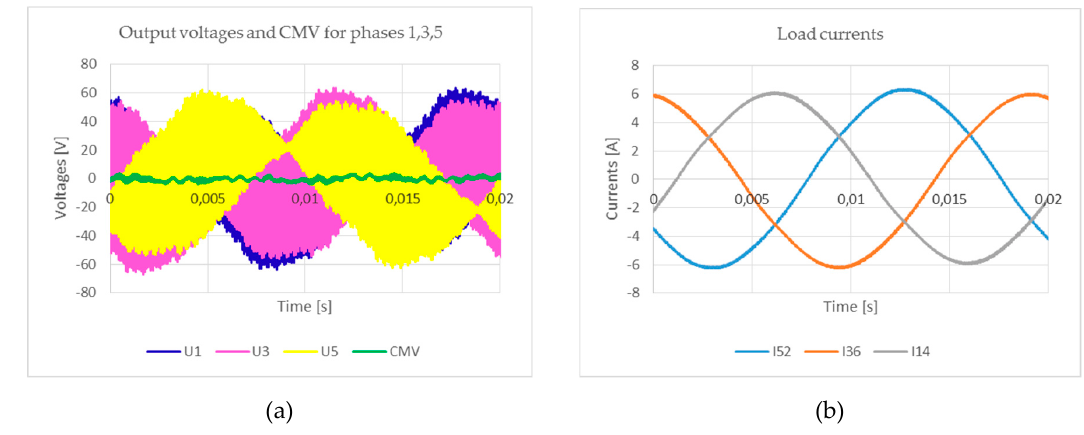
Figure 14. Waveform of the output phase voltages for phase 1,2 and 3 (dark blue, pink, yellow) and the CMV (green) (a), load currents (b), synthesized in the MC controlled by the use of the CCW rotating space vectors for three-phase open-end load and output frequency of 50 Hz.